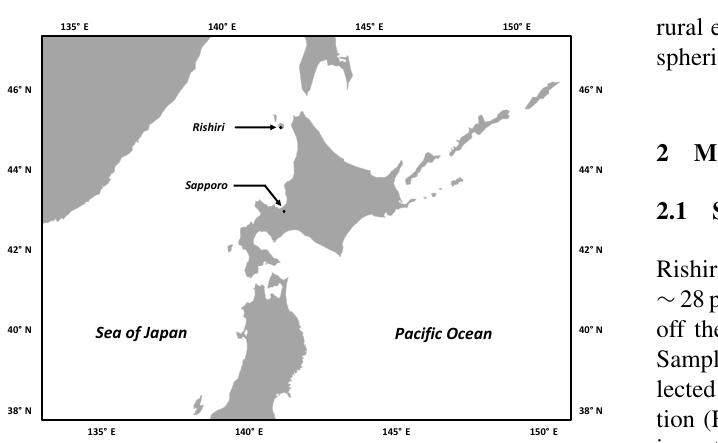
Figure 2. Location of study sites, Rishiri and Sapporo, in northern Japan. The base layer of the map was obtained from https://www.